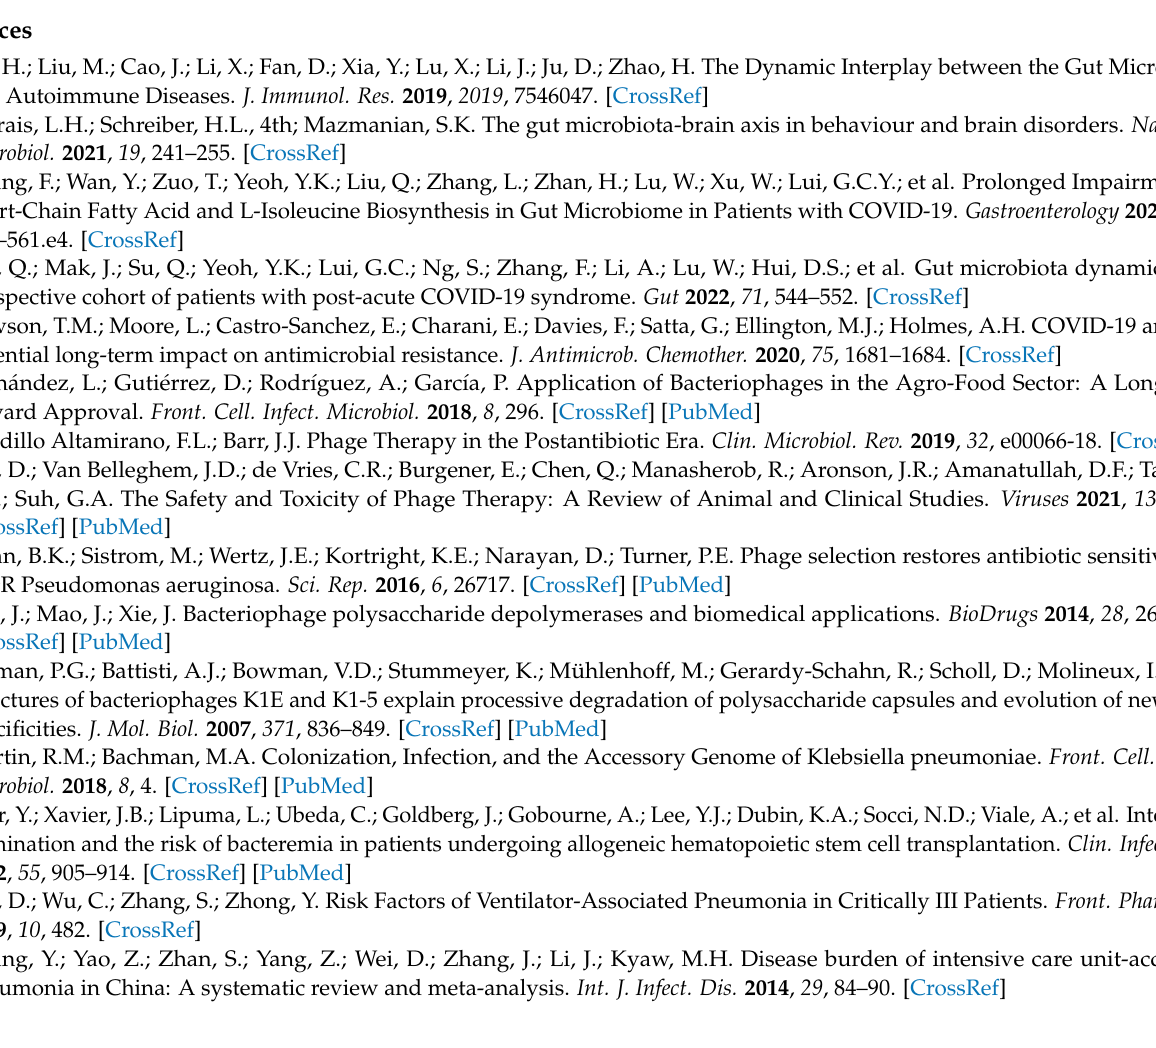
Table S1: clinical and laboratory parameters in the control group. Data are presented as the median and interquartile range (IQR); Table S2: CT lung volume assessment in subjects on bacteriophage therapy (BPh); Figure S1: lung CT data visualization using the “Ground glass” software (patient ID 20). Lung capacity 3220 cm 3 , lung damage 800 cm 3 (26%), left lung damage 436 cm 3 (22%), right lung damage 364 cm 3